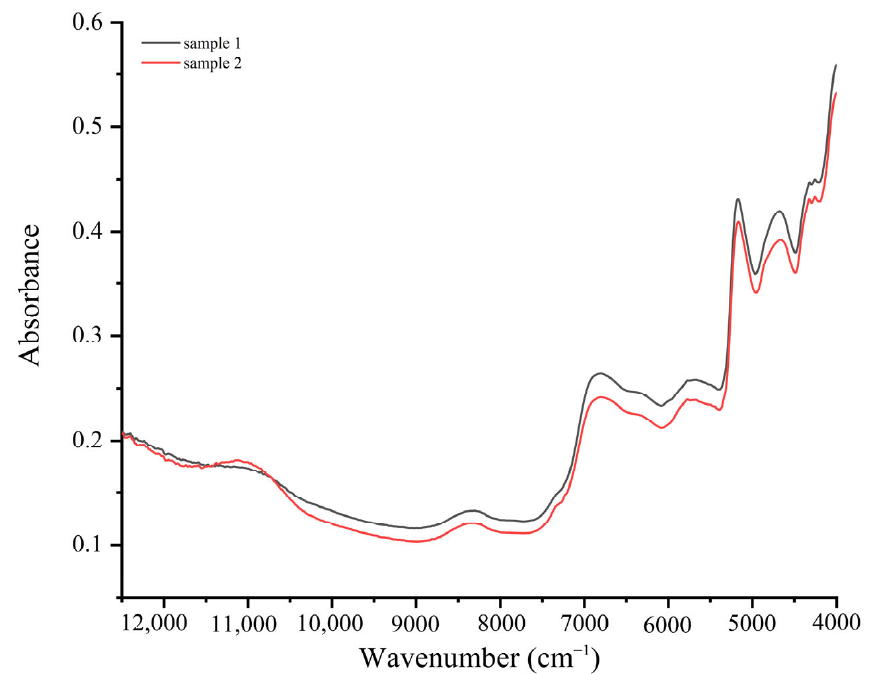
Figure 1. Golden Tartary buckwheat leaves’ original near-infrared spectrum. Sample 1 and sample 2 represents: two varieties of Golden Tartary buckwheat with different leucine and tyrosine contents in leaves.